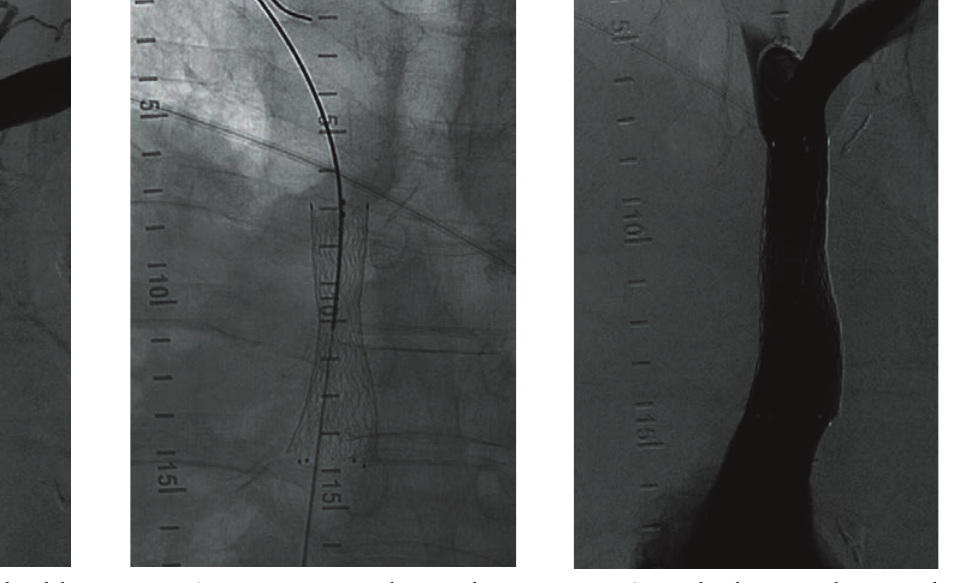
Fig. 1. Digital subtraction angiography of the superior vena cava (cavography) with evidence of severe lumen reduction (type II, Stanford classification).